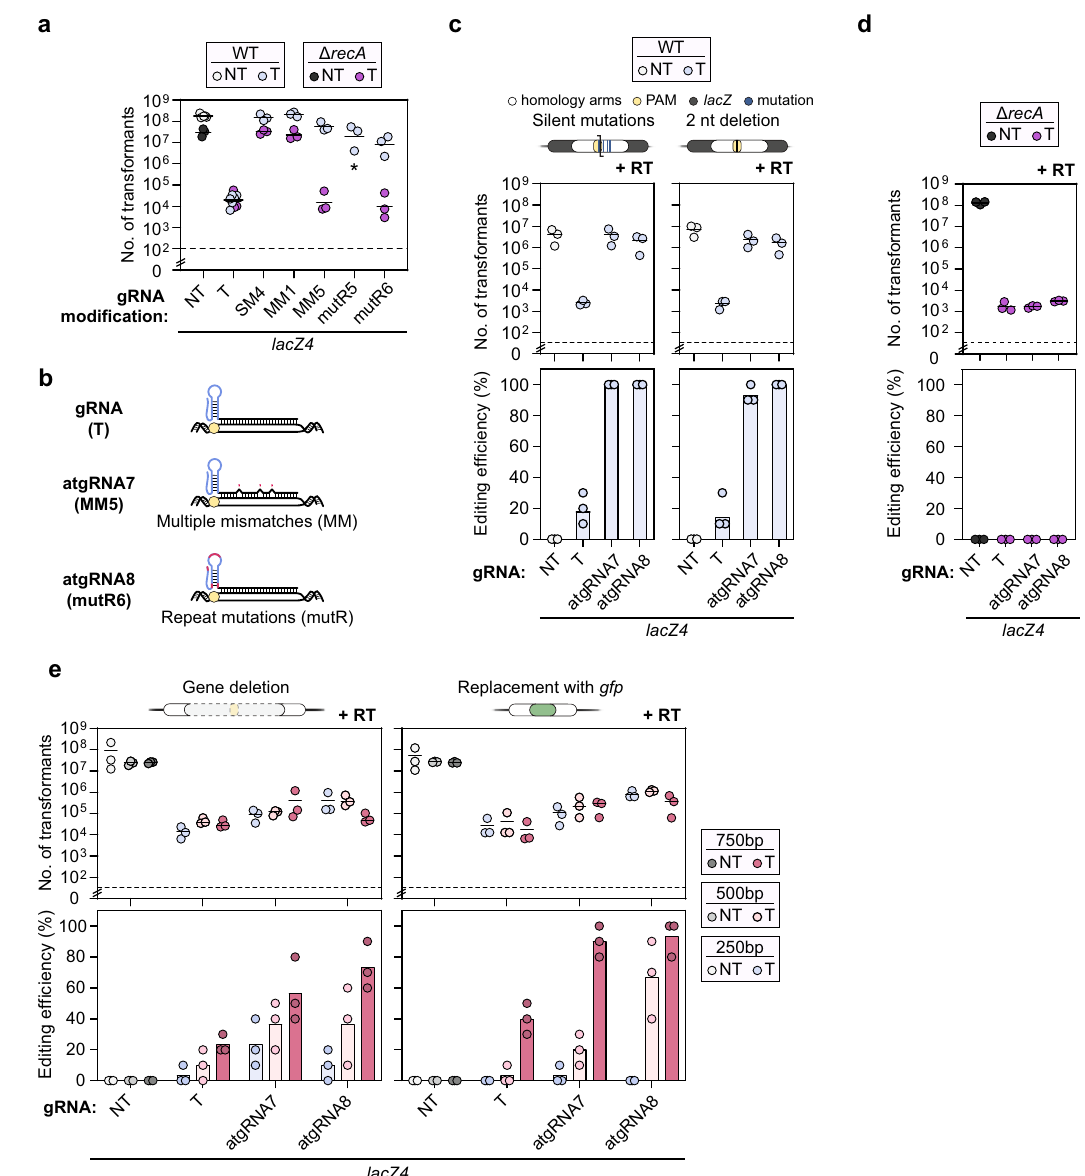
Fig. 3 | CRISPR-driven editing with attenuated gRNAs extends to Cas12a. a Genome targeting assay in E. coli and E. coli Δ recA with modi fi ed gRNAs and Cas12a. b SchematicofatgRNAsforCas12a. c) Genomeeditingassayin E.coli using atgRNAs to introduce a RE silent mutation (left panels) and a 2nt deletion in the lacZ ORF (right panels). d Editing assay to an AclI restriction enzyme site into lacZ in the E. coli Δ recA strain. Each dot in the editing ef fi ciency graph represents the value obtained for 3 colonies ( n =3). e Genome editing assay in E. coli using atgRNAs to delete the entire lacZ gene (left panels) and substitute lacZ with gfp (right panels). Individual dots for the transformations indicate a single biological